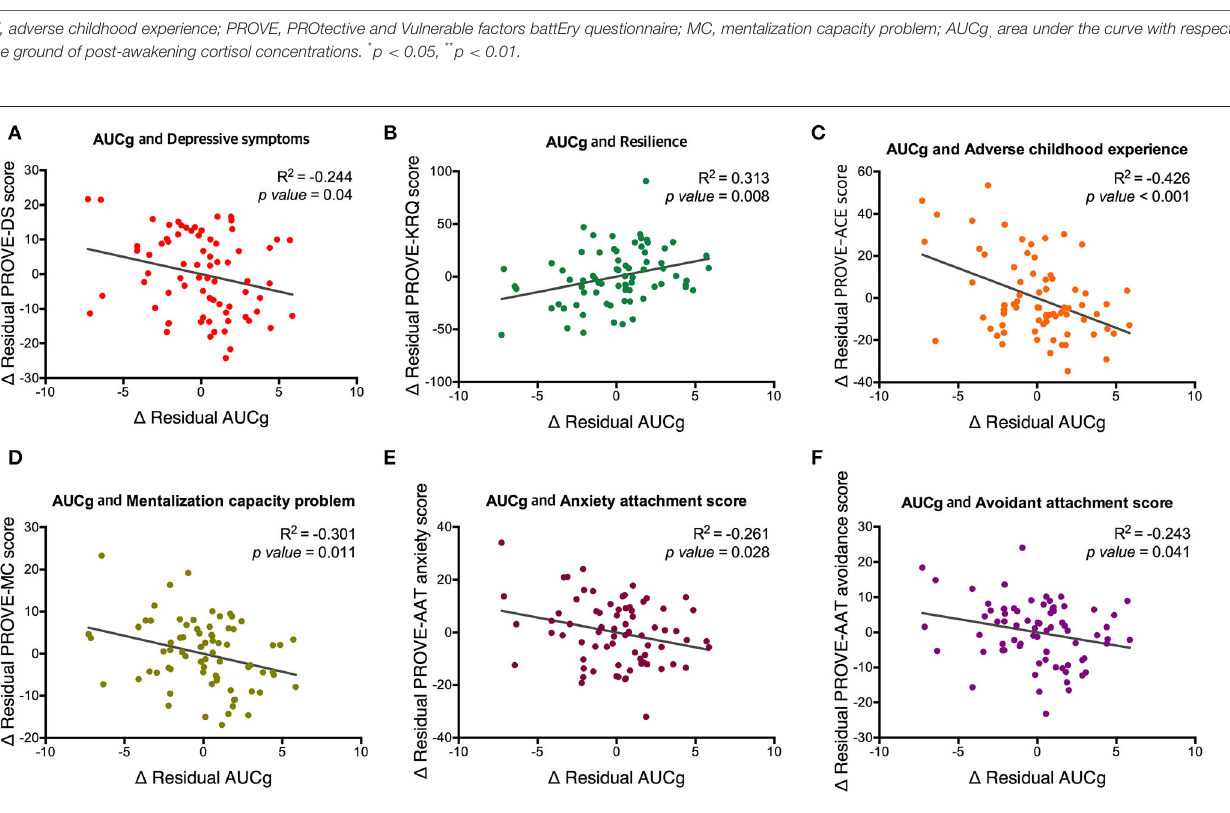
FIGURE 4 | Partial correlation between AUCg and psychological factors related to depression with covariates of age and sex. Associations of AUCg and (A) depressive symptoms, (B) resilience, (C) adverse childhood experience, (D) mentalization capacity problem, (E) anxiety attachment score and (F) avoidance attachment score are represented. PROVE, PROtective and Vulnerable factors battEry questionnaire; KRQ, Korean Resilience Quotient; ACE, adverse childhood experience MC, mentalization capacity problem; AAT, adult attachment type; AUCg, area under the curve with respect to the ground of post-awakening cortisol